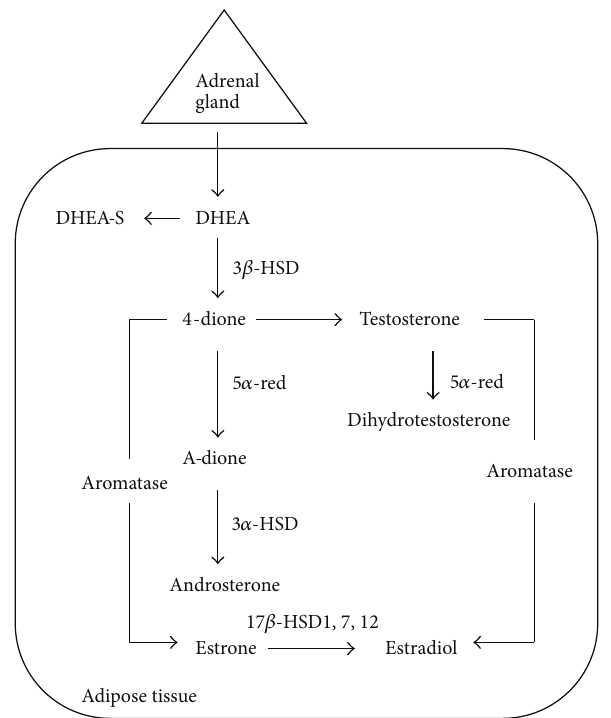
Figure 5: Sex steroidogenesis via the intracrine pathway. Androgens and estrogens synthesized in peripheral tissue including the breast require the presence of DHEA, an inactive precursor derived from the adrenal gland, and all of the appropriate enzymes. In addition to their synthesis, sex steroids are also inactivated in the same tissue thus minimizing widespread systemic effects. DHEA = dehydroepiandrosterone; DHEA-S = DHEA sulfated; 4-dione = androstenedione; A-dione = 5 𝛼 -androstenedione; 3 𝛼 -, 3 𝛽 -, and 17 𝛽 HSD = hydroxysteroid dehydrogenase; 5 𝛼 -red =